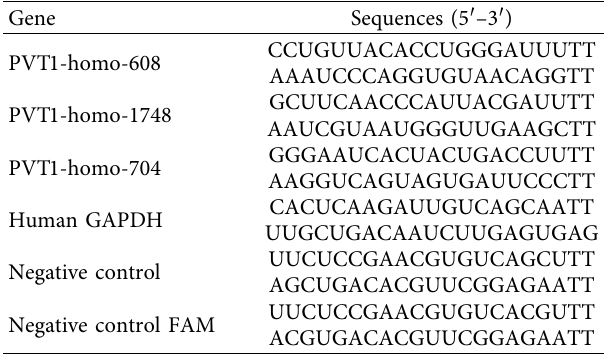
Table 1: Sequences of siRNA. Gene Sequences (5 ′ –3 ′